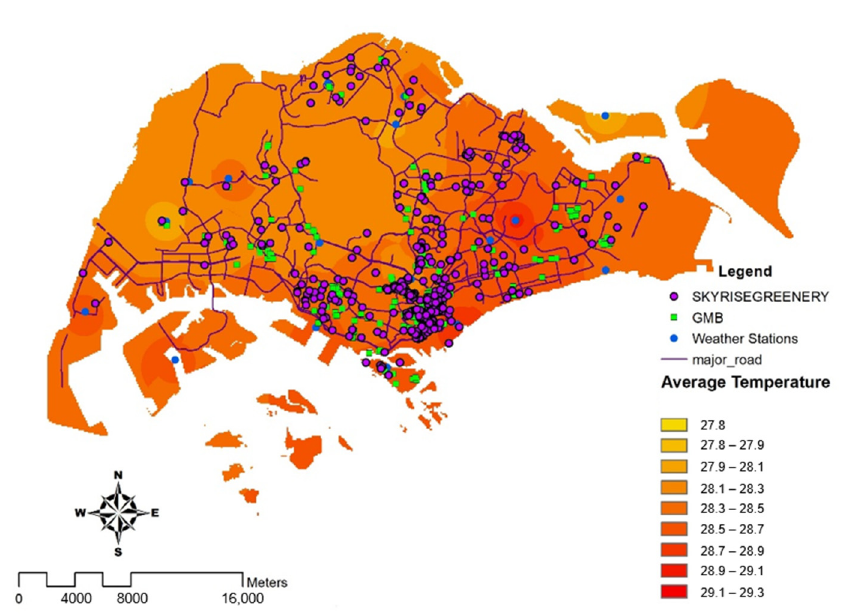
Figure 8. Annual Average Temperature (°C) in the year of 2019 in Singapore. Interpolation is used to calculate the average temperature based on a set of data obtained from meteorological stations.